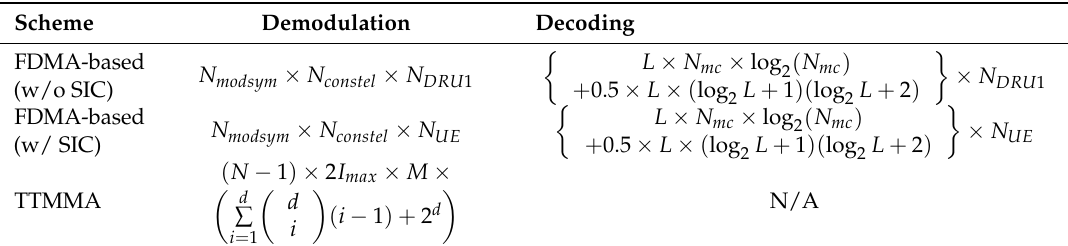
Table 2. Computational complexity of the FDMA-based discovery and trellis tone modulation multiple-access